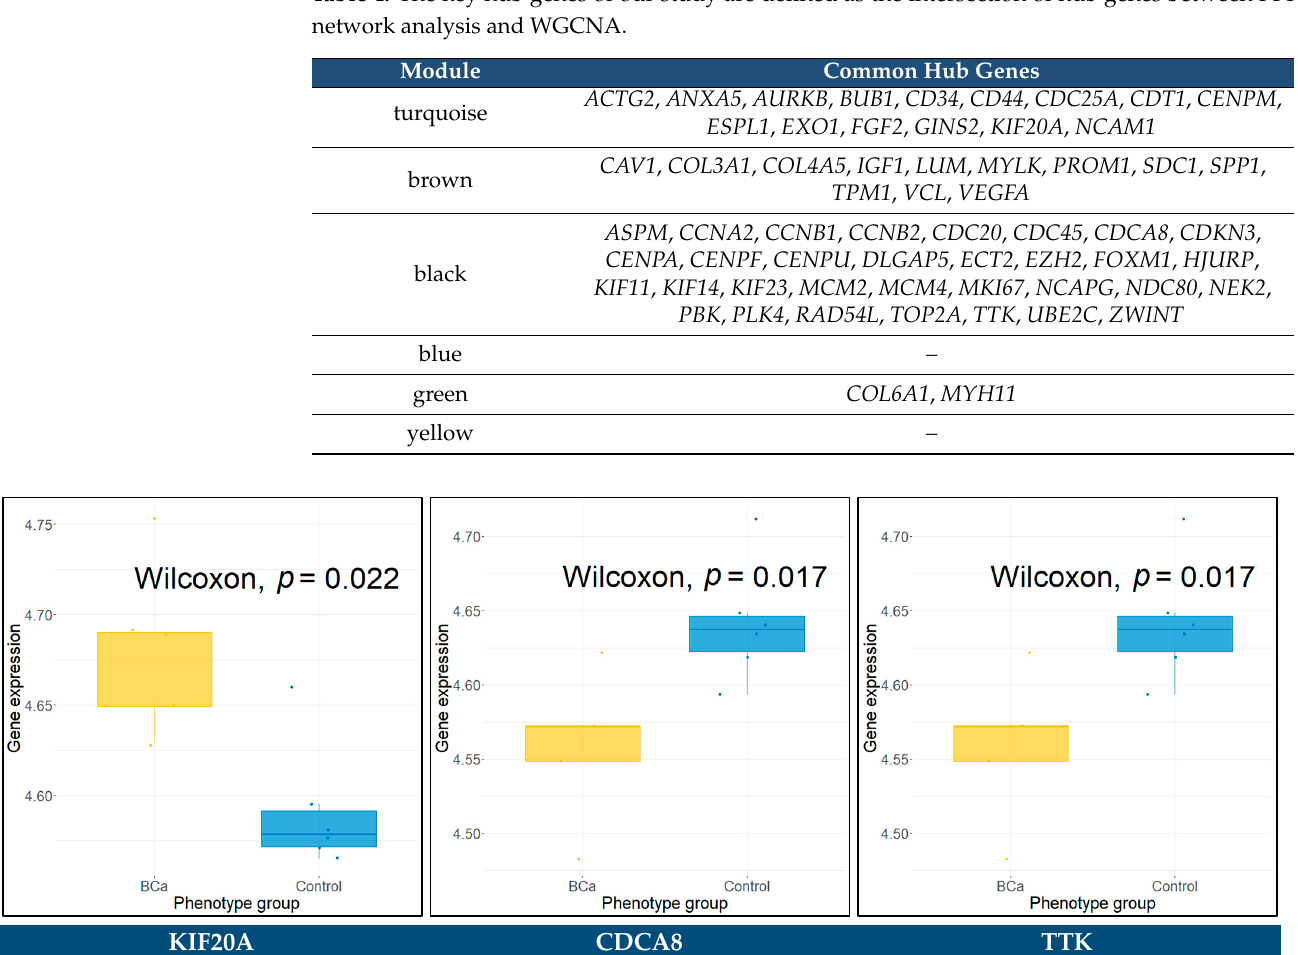
Figure 11. Significantly differentially expressed key hub genes in urine samples using the Wilcoxon rank sum test in GSE51843 ( n = 11).